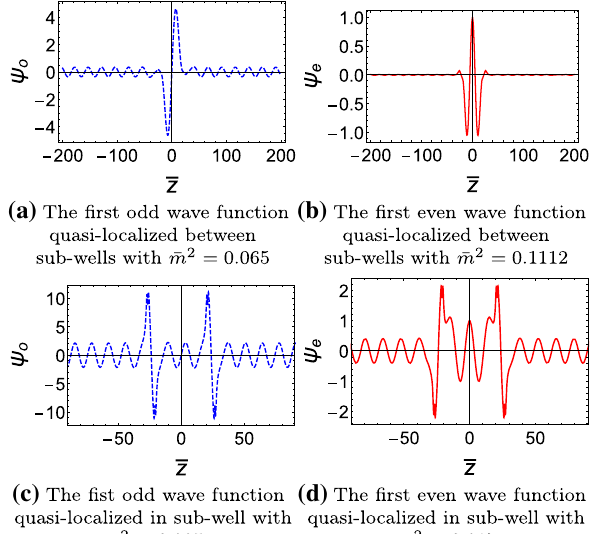
Fig. 24 The KK resonances between sub-wells and in a sub-well with ¯ b = 13, ¯ d = 2 . 3, and ¯ α = − 0 . 0838 for case 3